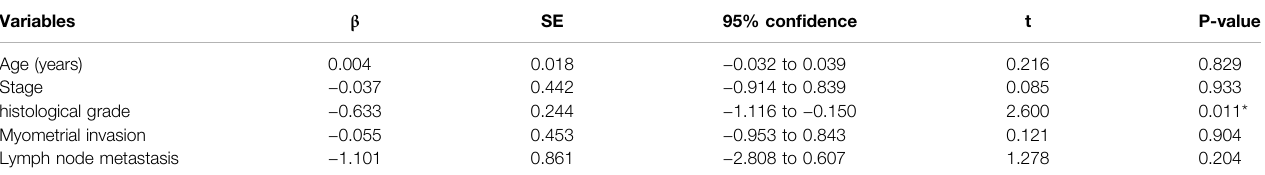
TABLE 2 | Multiple regression analysis of in fl uencing gene expression. * p < 0.05, ** p < 0.01, *** p < 0.001. Variables